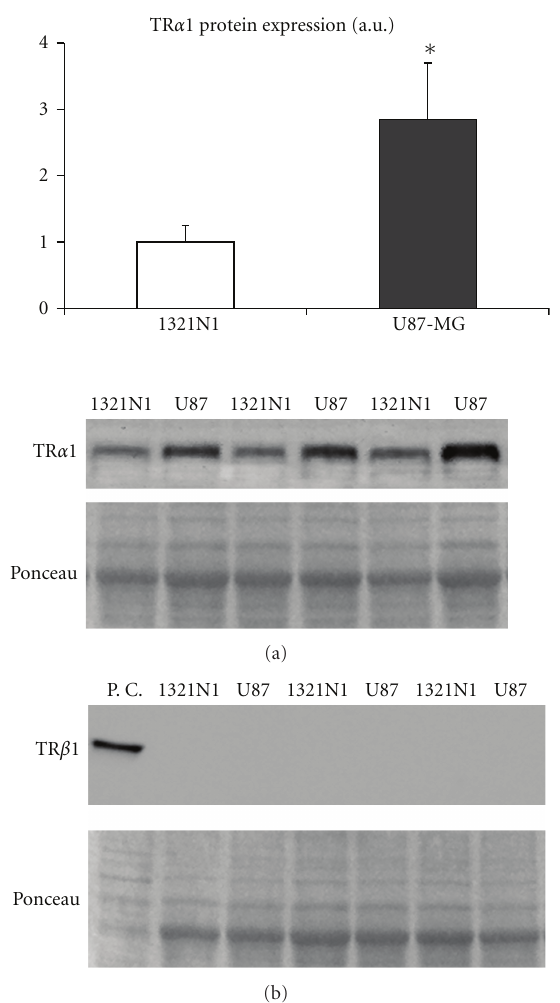
Figure 5: Phosphorylated levels of Akt and p44, p42 ERK after ex- posure of U87-MG cells for 2 days (a) and 4 days (b) in 1 nM T3 as compared to non treated cells. Data were derived from n = 5 samples in each group. Representative Western blotting images are shown. ∗ P < 0 . 05 versus non treated, ∗∗ P < 0 . 05 versus non treated and 1nM T3 treated